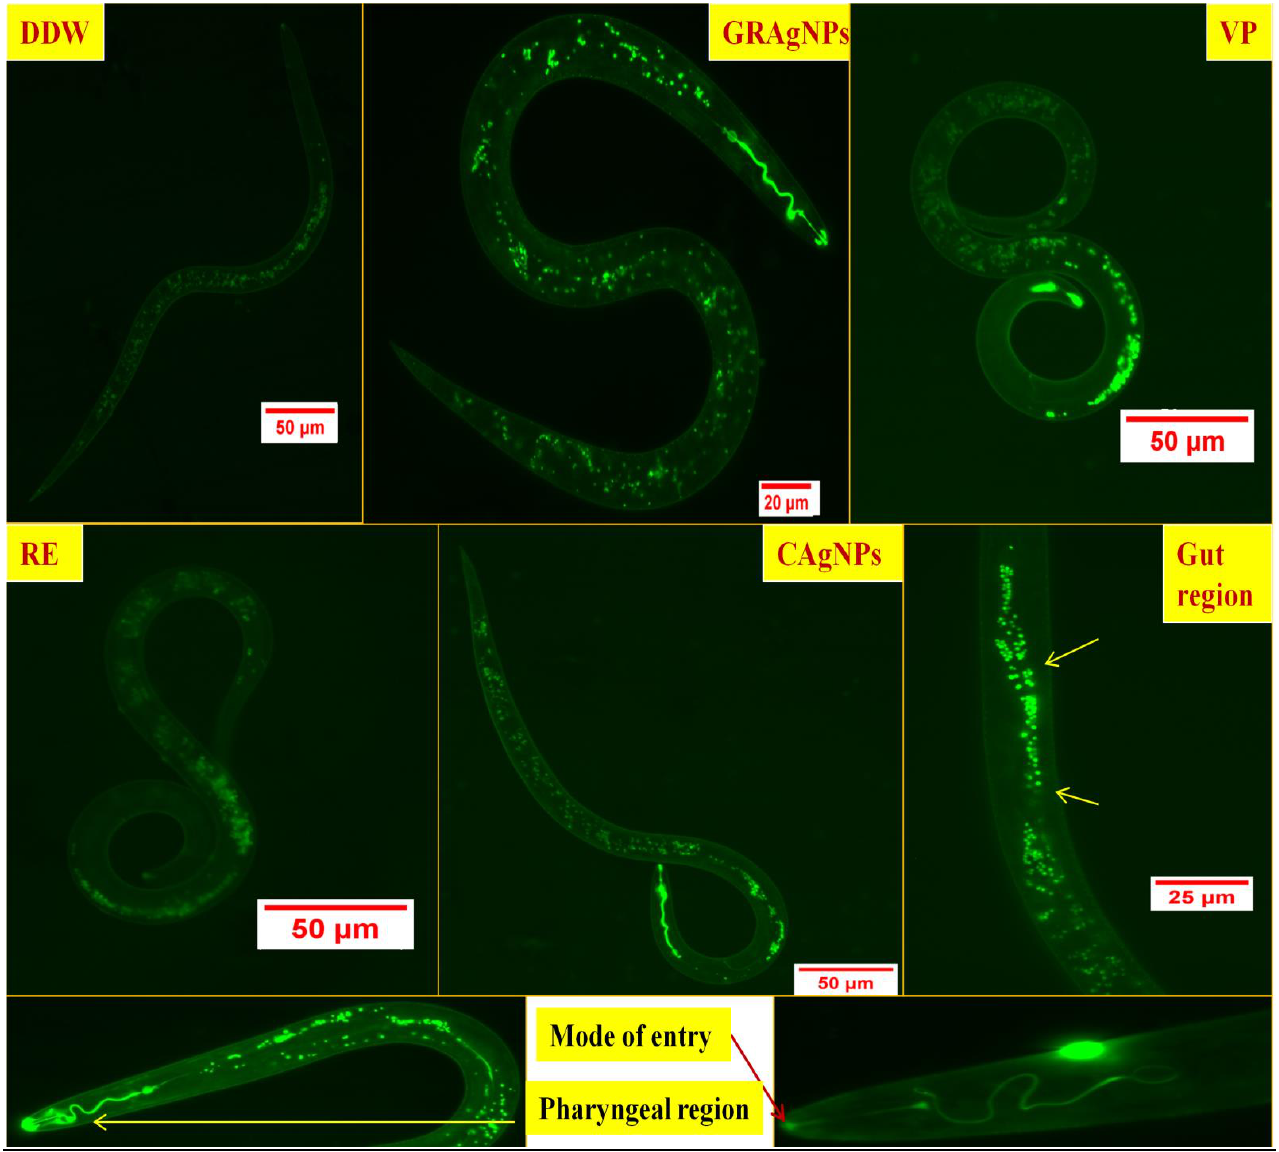
Figure 6. Fluorescent micrograph of uptake of GRAgNPs, CAgNPs, VP, and RE in M. incognita J2s. [Where, DDW = double distilled water, GRAgNPs = silver nanoparticles synthesized using aqueous root extract of G. glabra , VP = commercial nematicide, Velum prime, RE = aqueous root extract of G. glabra , and CAgNPs = commercial silver nanoparticles].